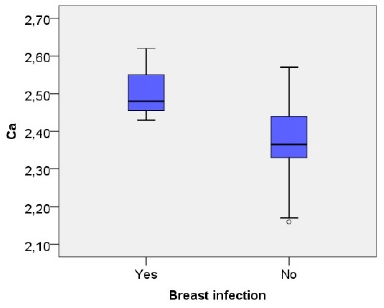
Figure 5. Calcium-levels related to reported breast infection, t -test, independent samples p < 0.01, unfilled circle indicates a value 1.5 × IQR or more below the third quartile. Table 3. Maternal breast complication and infant oral Candida colonization.